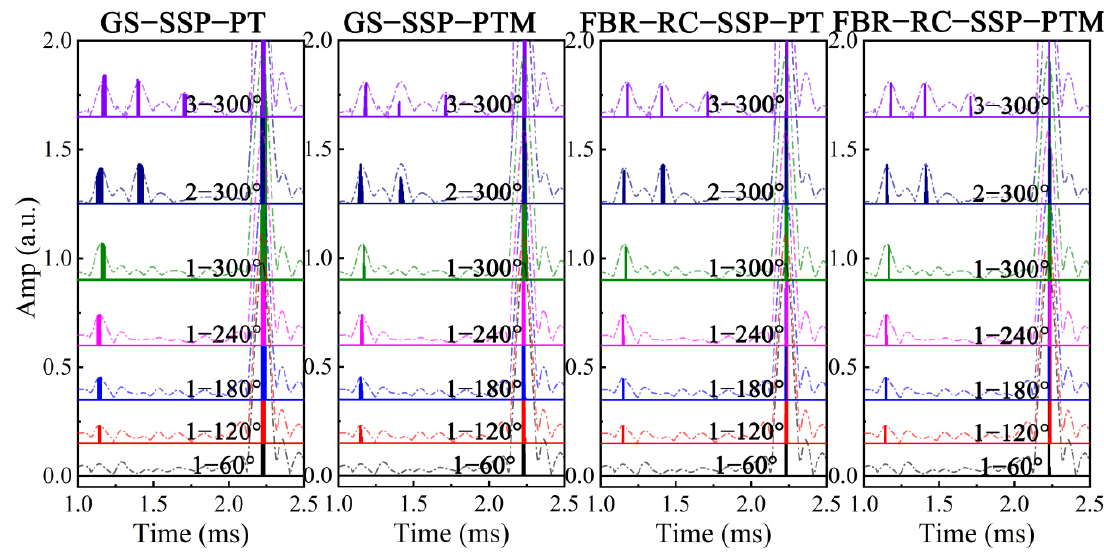
Figure 17. Experimental UGW signals before and after applying GS-SSP and FBR-RC-SSP (1 ≤ defect number ≤ 3, 60° ≤ α ≤ 300°). Table 3. SNRGs and DCRGs of experimental UGW signals processed by FBR-RC-SSP.